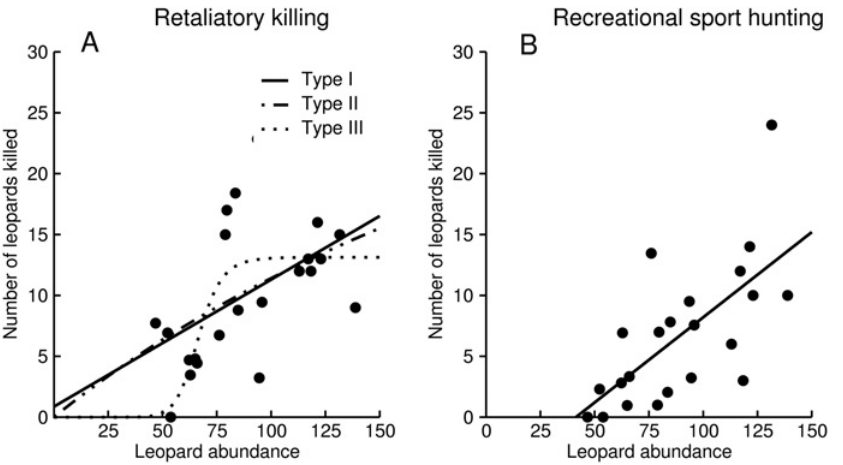
Fig 2. Relationships between leopard abundance and number of animals killed in retaliatory killing (200 leopards; A) and recreational sport hunting (133 leopards; B) in the Waterberg District Municipality, Limpopo Province, South Africa. Number of animals killed and abundance represent number of animals within one 2500 km 2 sample